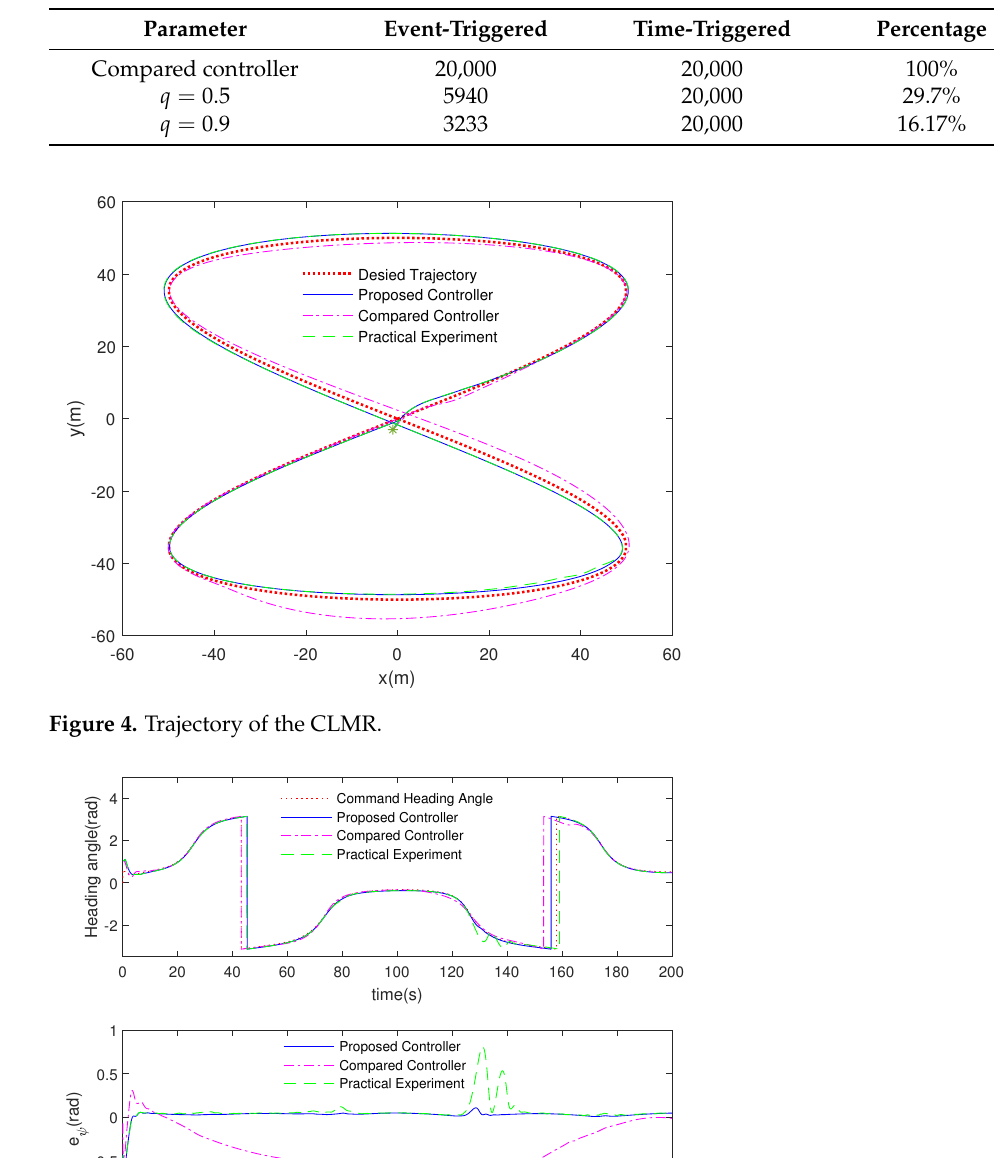
Table 2. Trigger times and percentage for communication.